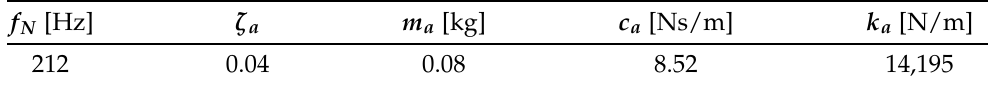
Table 7. Parameters of the